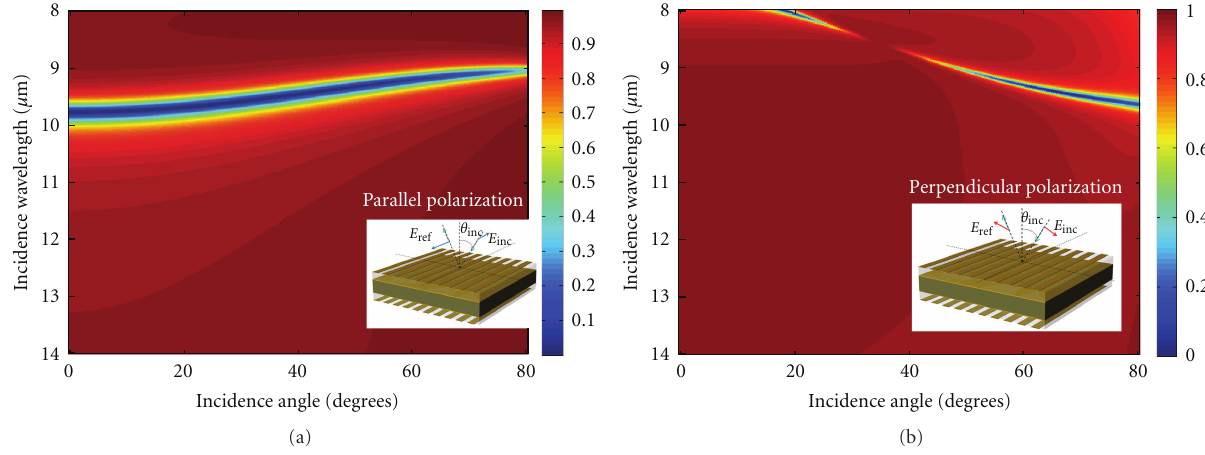
Figure 7: RCW predictions illustrating the sensitivity of our resonant structure with incident angle. The plot on the left (a) is for parallel polarization, while the plot on the right (b) is for perpendicular